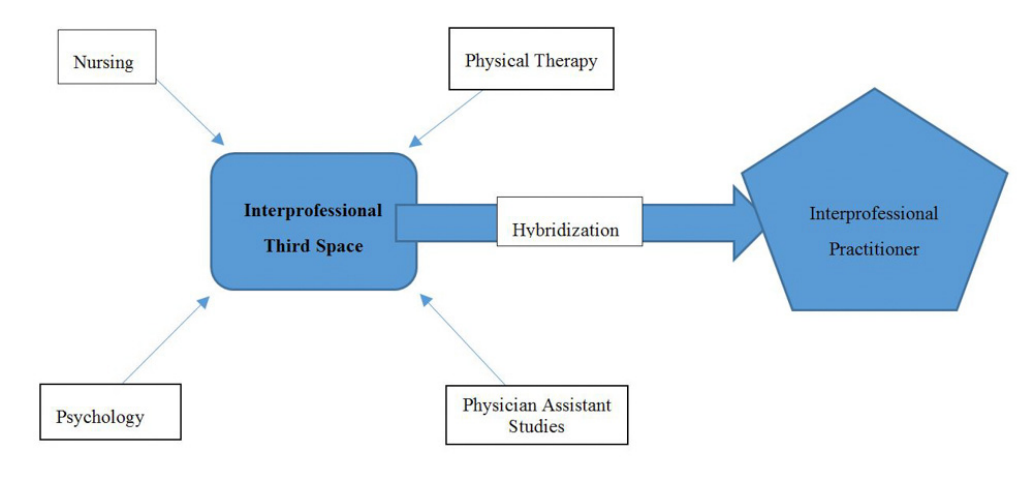
Figure 1. Process of interprofessional